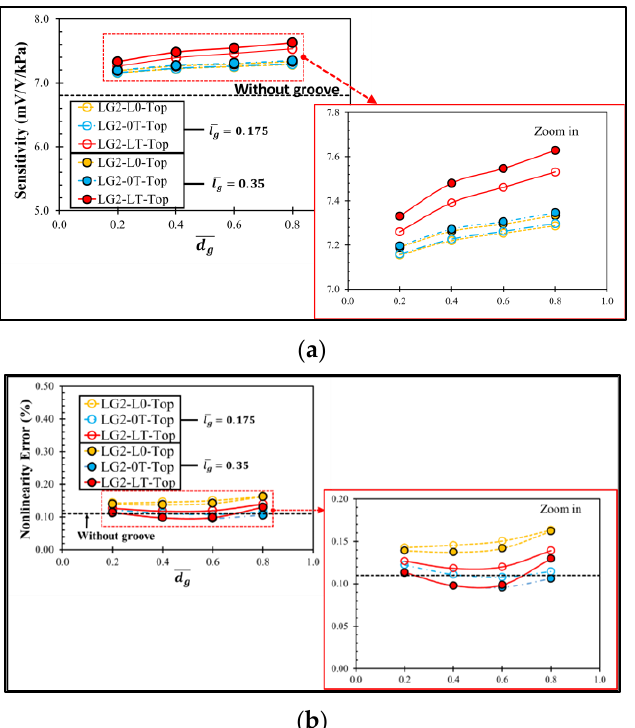
Figure 13. Effects of 𝑙 𝑔 ̅ on ( a ) sensitivity and ( b ) nonlinearity error of sensor with local groove 𝐿𝐺2 on the top of diaphragm.